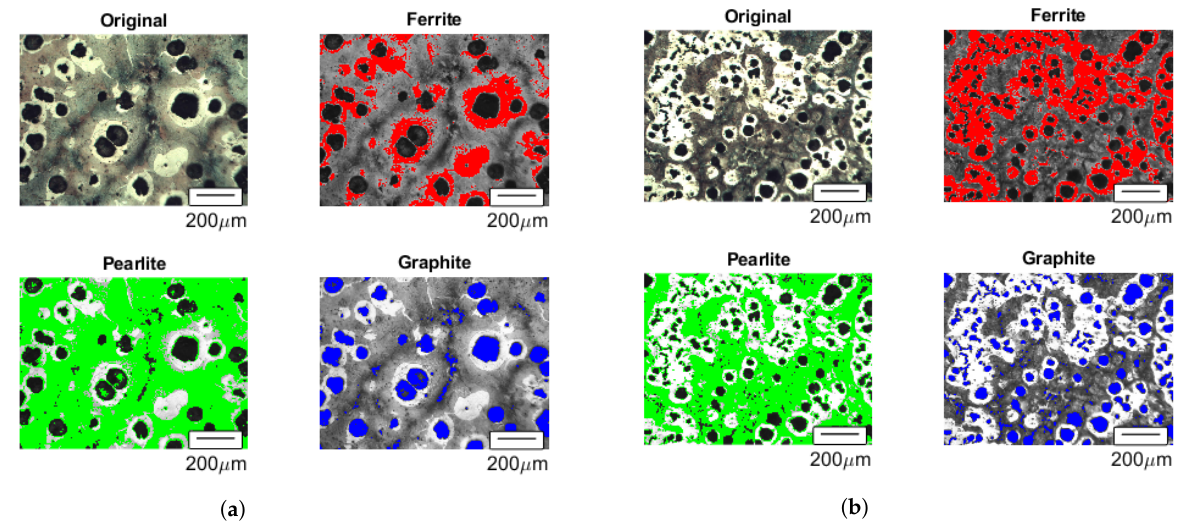
Figure 22. Computational image analysis of NCI GGG60 with graphite, ferrite and pearlite identifica- tion for round bar specimens. ( a ) Block specimens. ( b ) Round bar specimens.